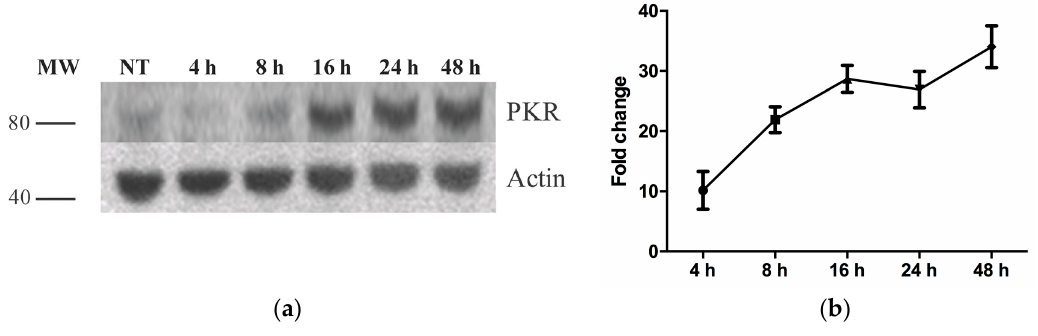
Figure 2. Time course analysis of PKR protein ( a ) and mRNA ( b ) expression in CHSE-214 after recombinant IFN- α treatment detected by Western blot using 1:1000 dilution of the custom-made antibodies ( a ) and real-time PCR ( b ). The real-time data are expressed as the mean fold changes in gene expression for IFN- α treated samples relative to the untreated control after normalization to β -actin ( n = 2). MW = molecular weight; NT—non-treated; different time points are post IFN treatment.